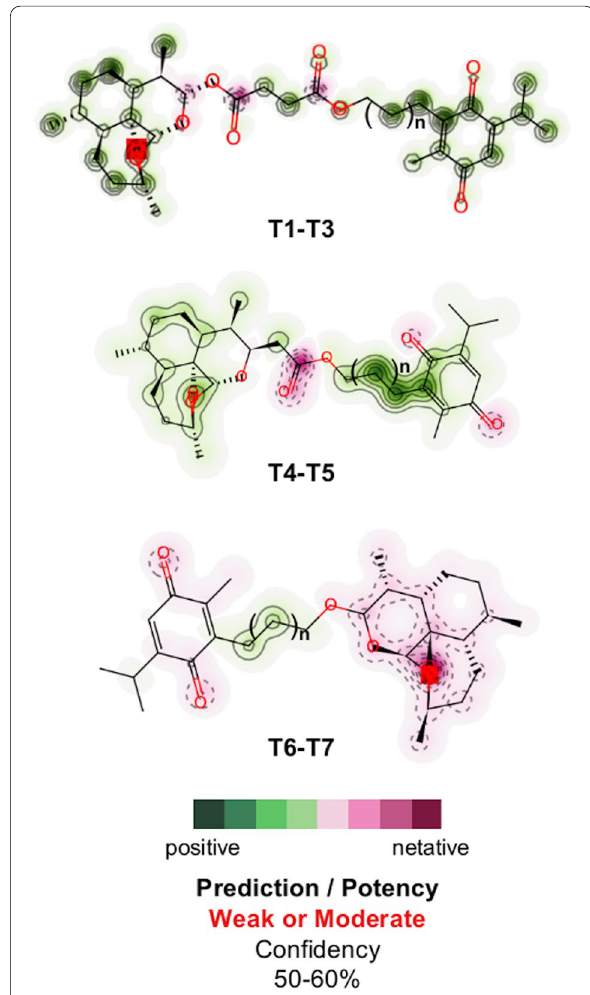
Fig. 11 hERG blocking probability map of parental and hybrid compounds (pharmacophore). Positive (green) and negative (pink) structural contributions of T1–T7